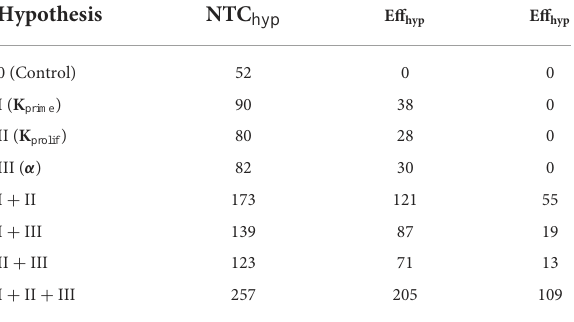
TABLE 2 Calculated effects of anti CTLA-4 inhibition for the various mechanistic hypotheses, as estimated using Equations 6, 7 (for combinations of